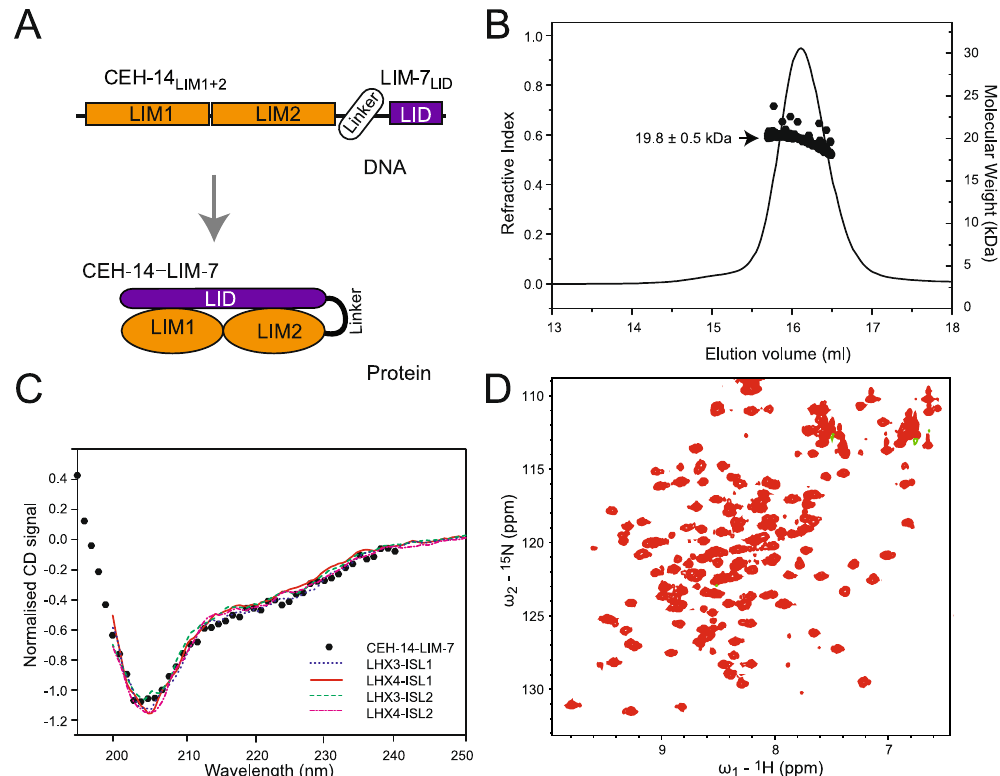
Figure 3. A ‘tethered’ CEH-14–LIM-7 complex. ( A ) Schematic of the CEH-14–LIM-7 tethered complex. Based on data from similar complexes, introducing a tether between the LIM1 + 2 domains from CEH-14 and the LID from LIM-7 was expected to stabilise the complex and facilitate structural characterisation. This engineering approach takes advantage of the close positioning of C-and N-termini in the native complexes. ( B ) SEC-MALLS data for CEH-14–LIM-7 in 20 mM Tris, pH 8.0, 150 mM NaCl, 1 mM DTT at 0.5 ml/min at 25 °C (black line, refractive index profile; black dots, MW distribution). ( C ) Far UV-CD profile of CEH-14–LIM-7 (5 μ M black dots) in 10 mM Tris-HCl pH 8.5, 150 mM NaF, 0.5 mM TCEP at 20 °C, compared to the spectra of related LHX3/4–ISL1/2 tethered complexes as indicated. Data for those complexes were published previously 12 . ( D ) 1 H- 15 N HSQC spectrum of CEH-14–LIM-7 (37 μ M) in 20 mM HEPES pH 7.0, 1 mM DTT at 25 °C recorded at